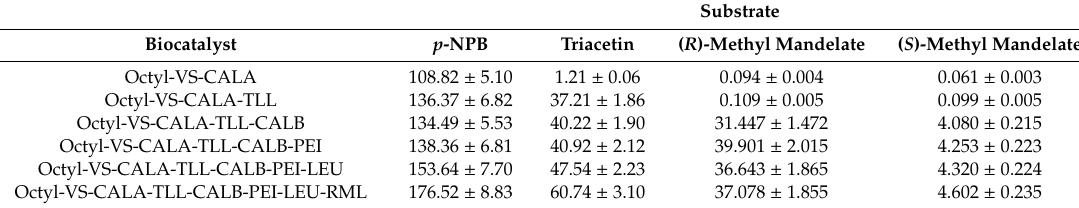
Table 3. Activities of the di ff erent lipase immobilized or co-immobilized biocatalysts during the construction of Octyl-VS-CALA-TLL-CALB-PEI-LEU-RML versus di ff erent substrates. Activities are given as U / g. Activities were determined as stated in Methods.